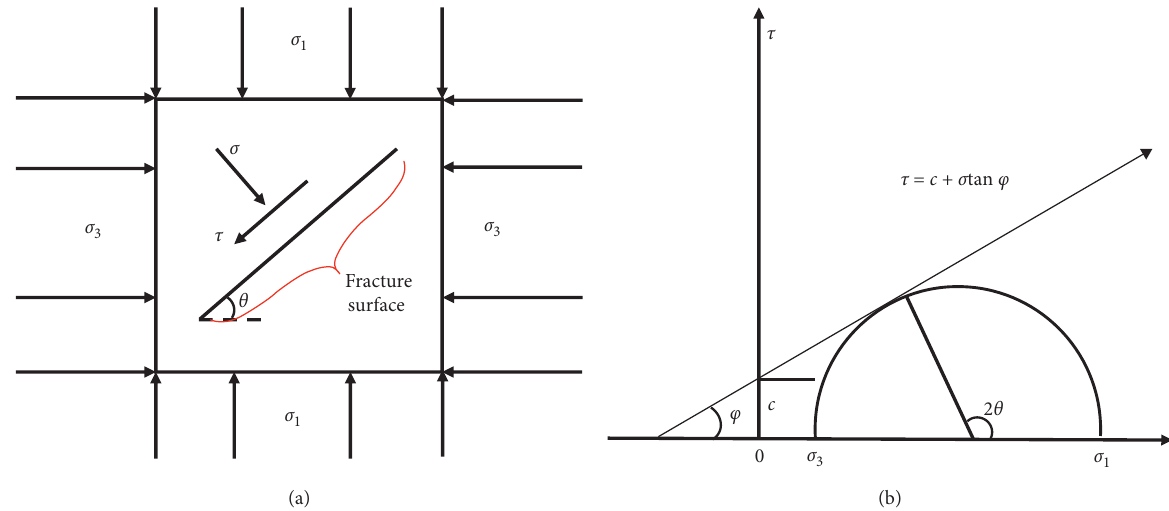
Figure 5: Stress analysis diagram of fractured rock mass under triaxial compression. (a) Fractured surface. (b) Mohr-Coulomb failure